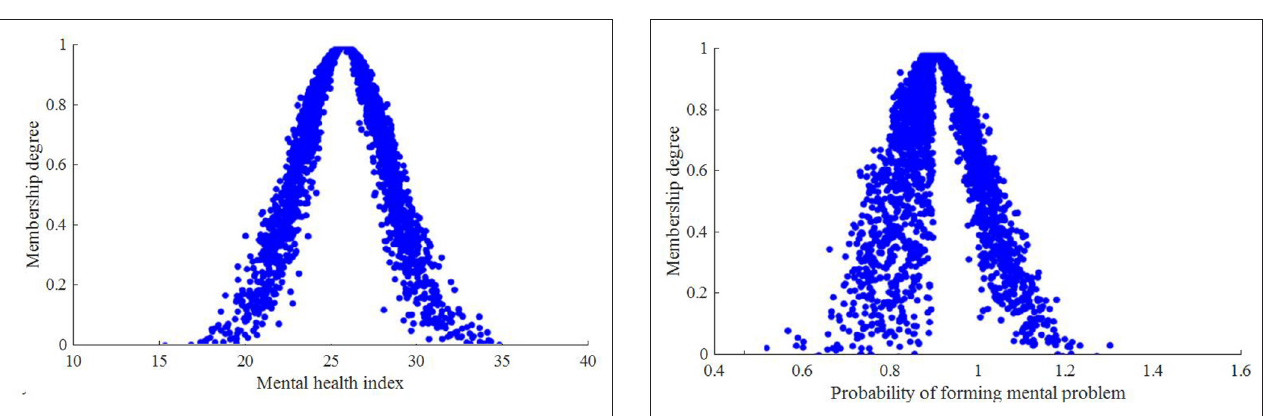
TABLE 1 | Probability of psychological well-being problem and psychological well-being index. Mental problem Probability of Mental health index mental problem Force